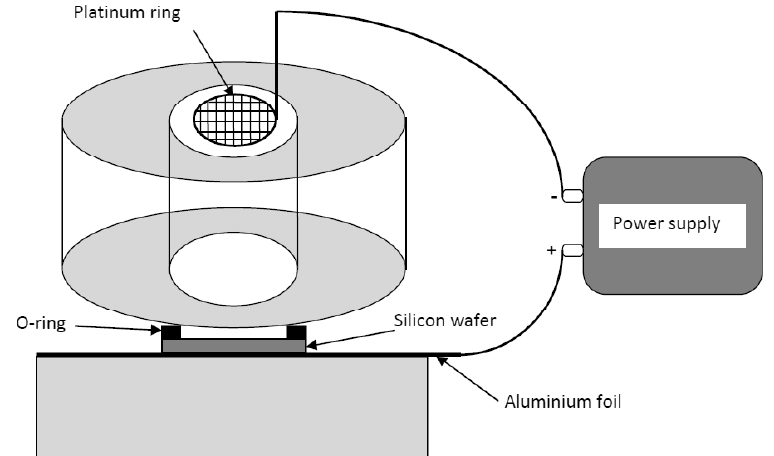
Fig. 2. Schematic diagram of etching cell used for PSi formation by electrochemical etching.